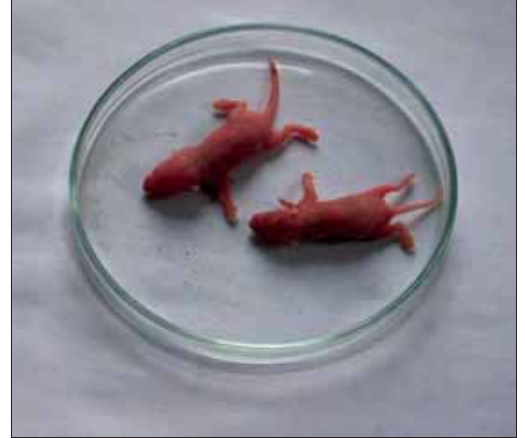
Figure-1: Paralysis in hind limb of baby mice inoculated with suspected Op samples (Positive results of presence of FMDV in samples).